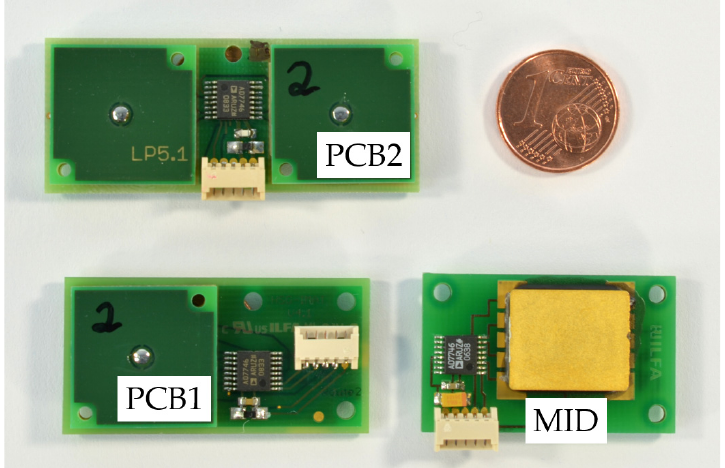
Figure 1. Three variants of the fluidic capacitive inclination sensors investigated in this work with different manufacturing processes. The different variants are described in detail in Section 3.1.1. MID Sensor and Section 3.1.2. PCB Sensor.